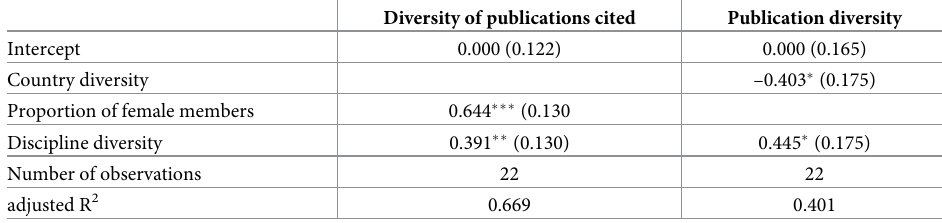
Table 2. The effect of input variables on citation and publication